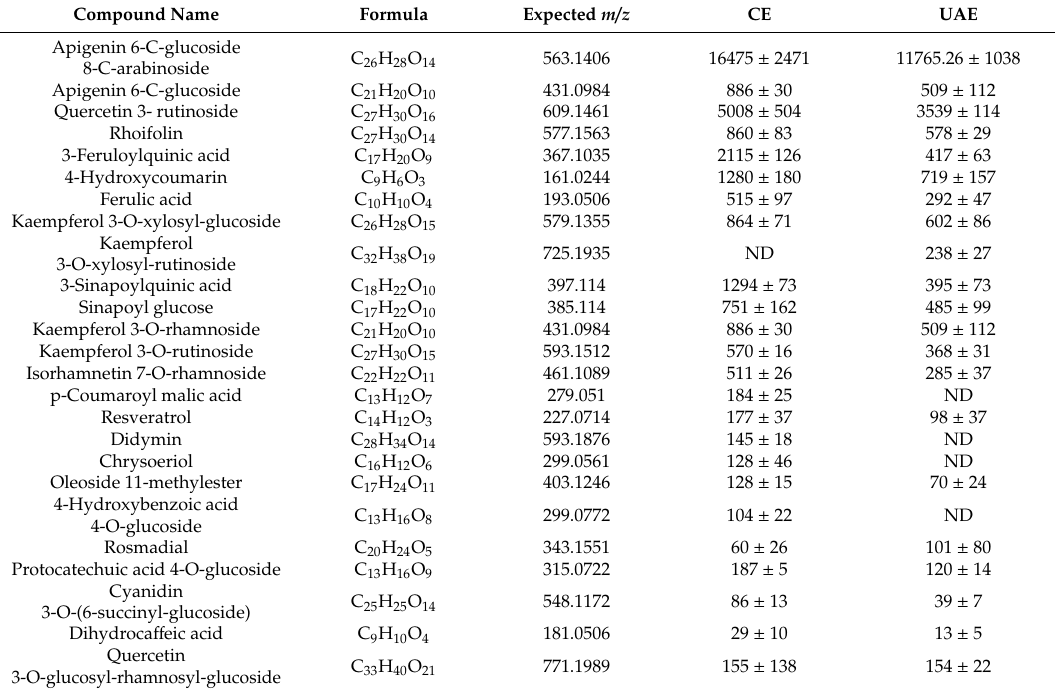
Table 2. Triple TOF-LC-MS-MS analysis of the polyphenols (mg / kg) in aqueous fig leaves extracts obtained with conventional (CE) and ultrasound-assisted (UAE) extraction